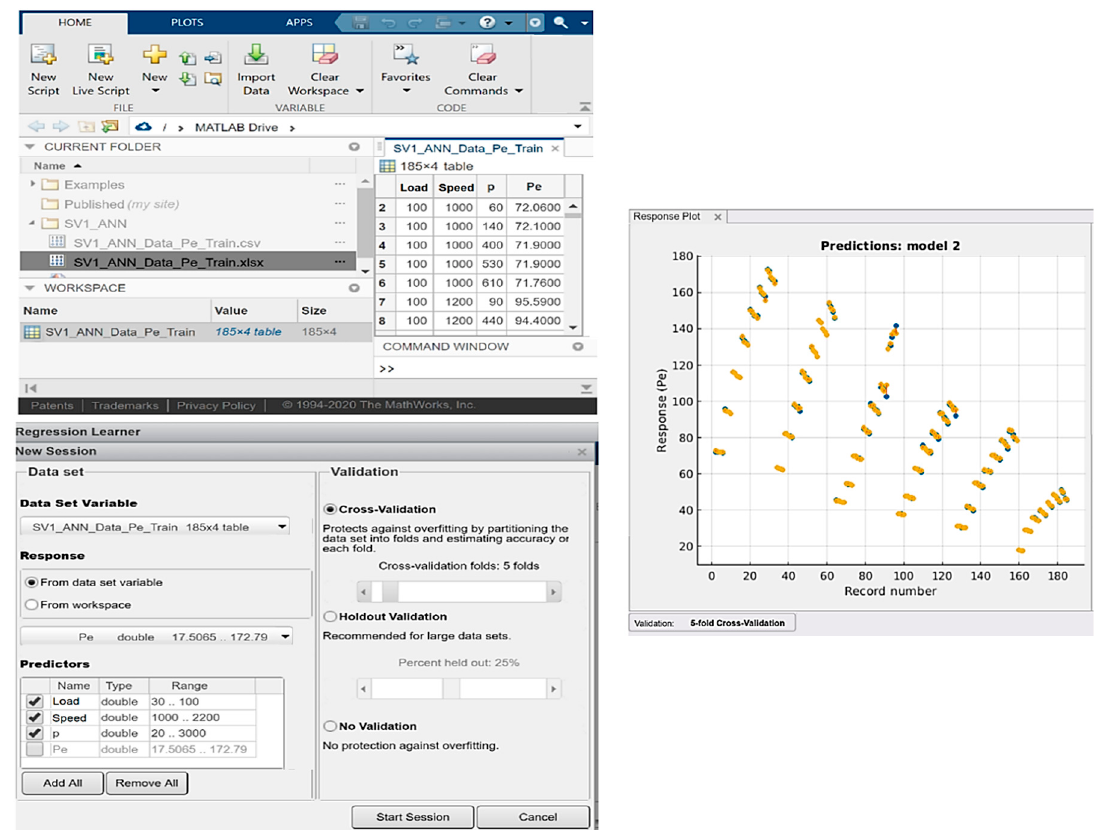
Figure A3. Performance of the AI cloud model suggested by MATLAB and Pe predictions vs. test values plot (to the right the predicted Pe values are plotted together with the values of the test data set, an intuitive illustration of the GPR algorithm’s performance).